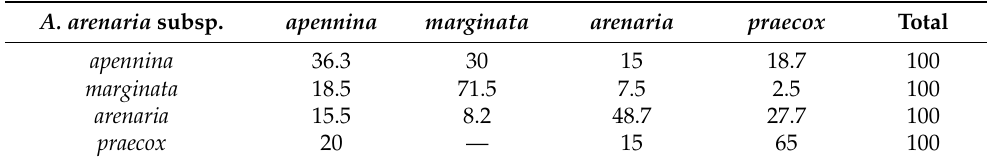
Table 4. Confusion matrix of the LDA based on the seed morpho–colorimetric dataset (percentages of correct classification), assuming the current taxonomic hypothesis of Armeria arenaria subspecies as a priori groups, as proposed by Arrigoni [17]. Rows show the membership of each a priori established group, whereas columns show the membership predicted by the classification model.